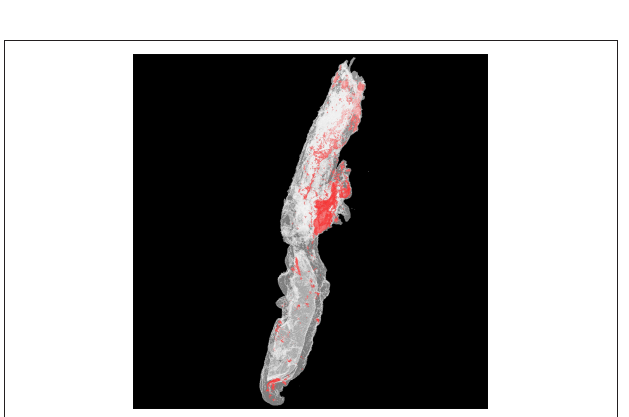
FIGURE 2 | 3D color visualization of a thrombus sample. A 3D model of a thrombus sample was created using CTAn software (Bruker, Kontich, Belgium), and color visualization was performed via CTVol software (Bruker, Kontich, Belgium). Erythrocyte-rich regions were rendered in red, whereas platelet-rich regions were rendered in